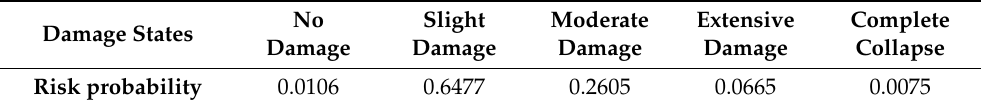
Table 10. Seismic risk probability.